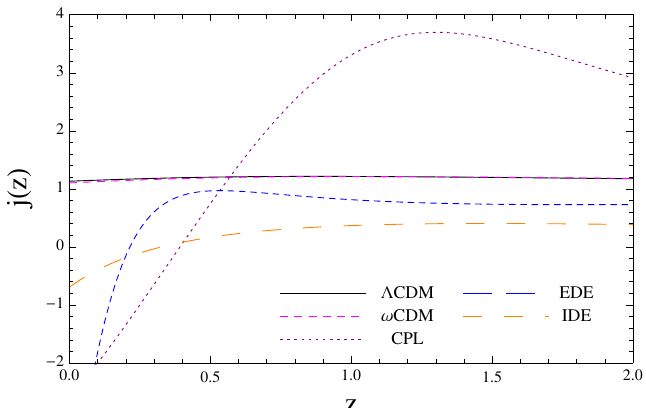
Figure 3. Jerk parameter vs. redshift using only GC data ( d A + f gas ). For cosmological models CPL, IDE and EDE we can observe a strong deviation from Λ CDM at present, while for wCDM this does not